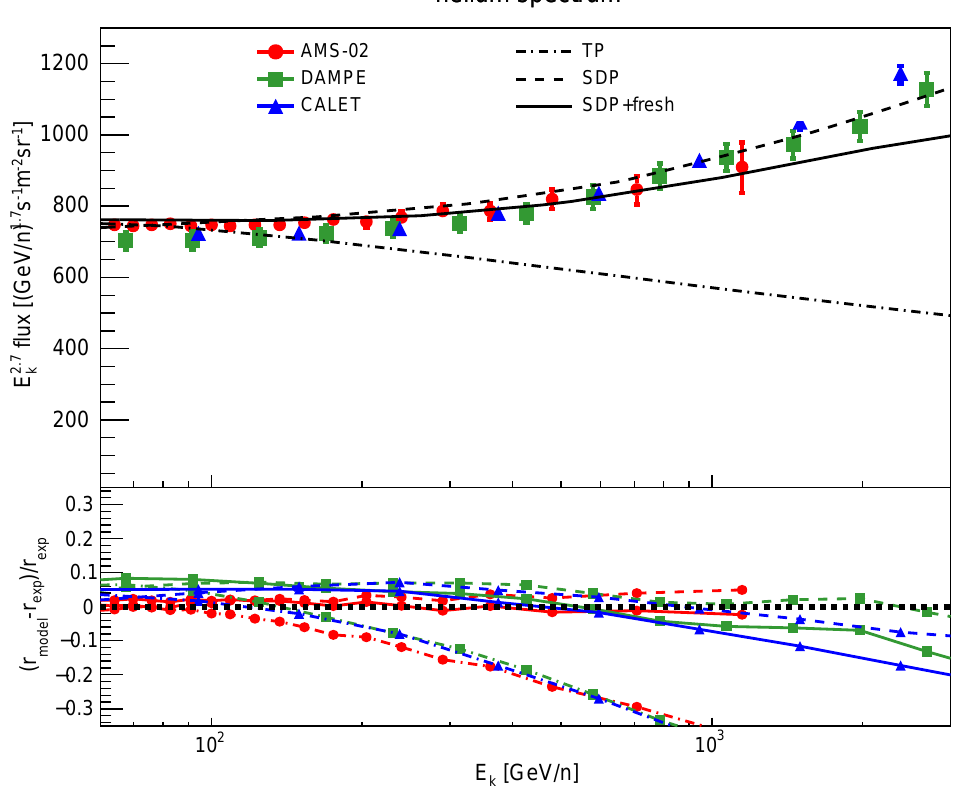
Figure 2. The model calculations of Helium spectrum from Traditional Propagation (TP), Spatially Dependent Propagation (SDP), and SDP + ”fresh” component models. The data are from the AMS − 02 − publication [10], DAMPE − publication [17], and CALET − puclication [62]. r model and r exp represent the model calculated value and the measured value of the experiment,